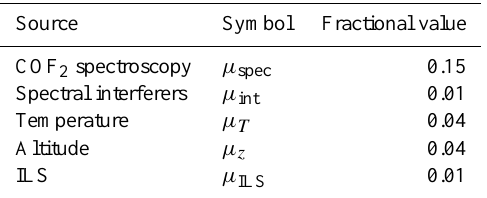
Table 5. Sources of systematic uncertainty in the ACE-FTS v3.0 carbonyl fluoride